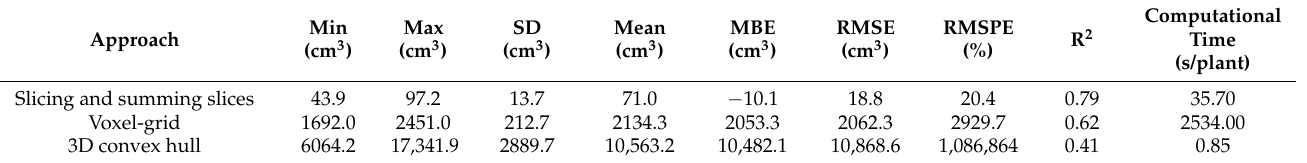
Table 1. Descriptive statistics of estimated strawberry canopy volume using three approaches (slicing and summing slice volume, voxel-grid, and 3D convex hull); errors are provided in terms of mean bias error (MBE), root mean square error (RMSE), root mean square percent error (RMSPE), coefficient of determination (R 2 ) between estimated and reference volume ( n = 12), and average computational time per